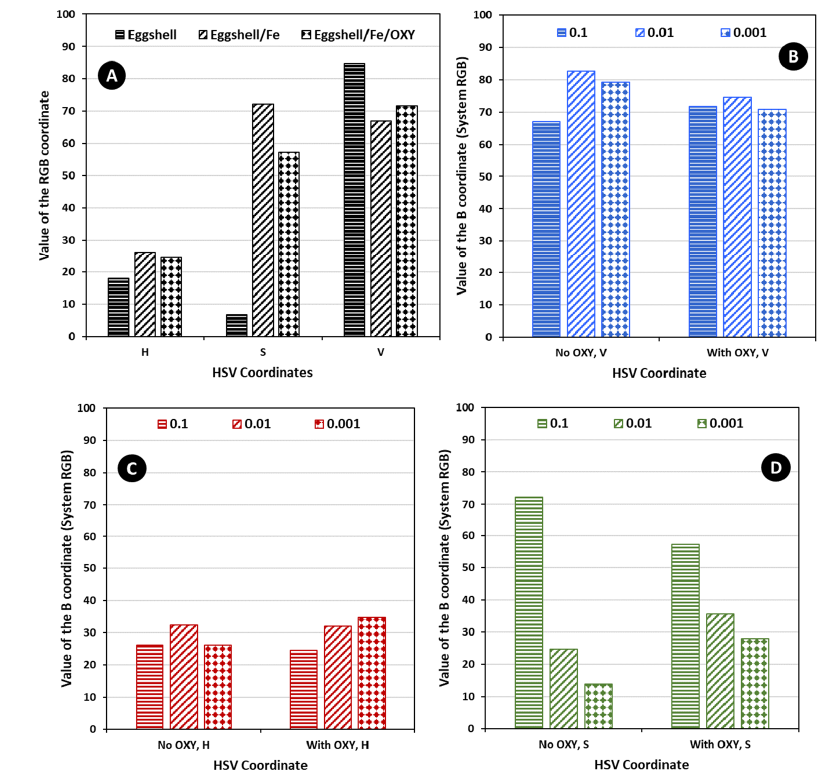
Figure 5. Average values of the HSV coordinates for at least 3 random measures in Paint, ( A ) for the various stages of material modification, setting the concentration of iron to 1.0 × 10 −1 mol/L, and ( B – D ) for a given coordinate value obtained with the several concentrations of iron tested. Sensors 2022 , 22 , x FOR PEER REVIEW